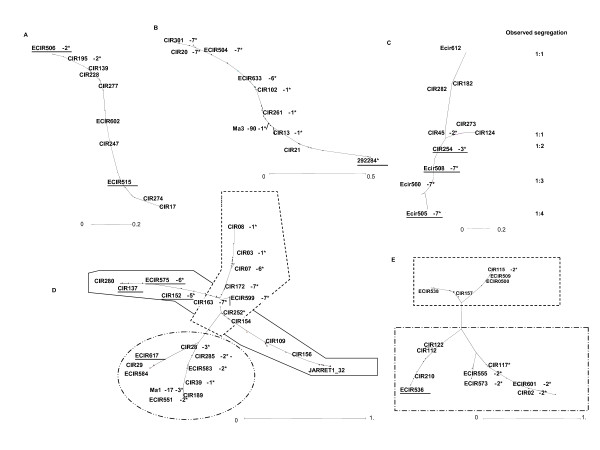
Neighbor-joining trees designed from different linkage group data of P. Lilin. A: PLG 5 showing perfect alignment of markers, B: PLG 3, C: PLG 10 showing inverted segment; D: PLG 1+2+4 showing anchor markers belonging to BLG 1 (- -), BLG 4 (--), BLG 2 (- · · -) on Borneo, E: example of artificial grouping of the independent PLG 7 (- · · -) and PLG 11 (--) at LOD 1. Markers on linkage groups are anchor markers, except underlined ones which are P. Lilin markers.